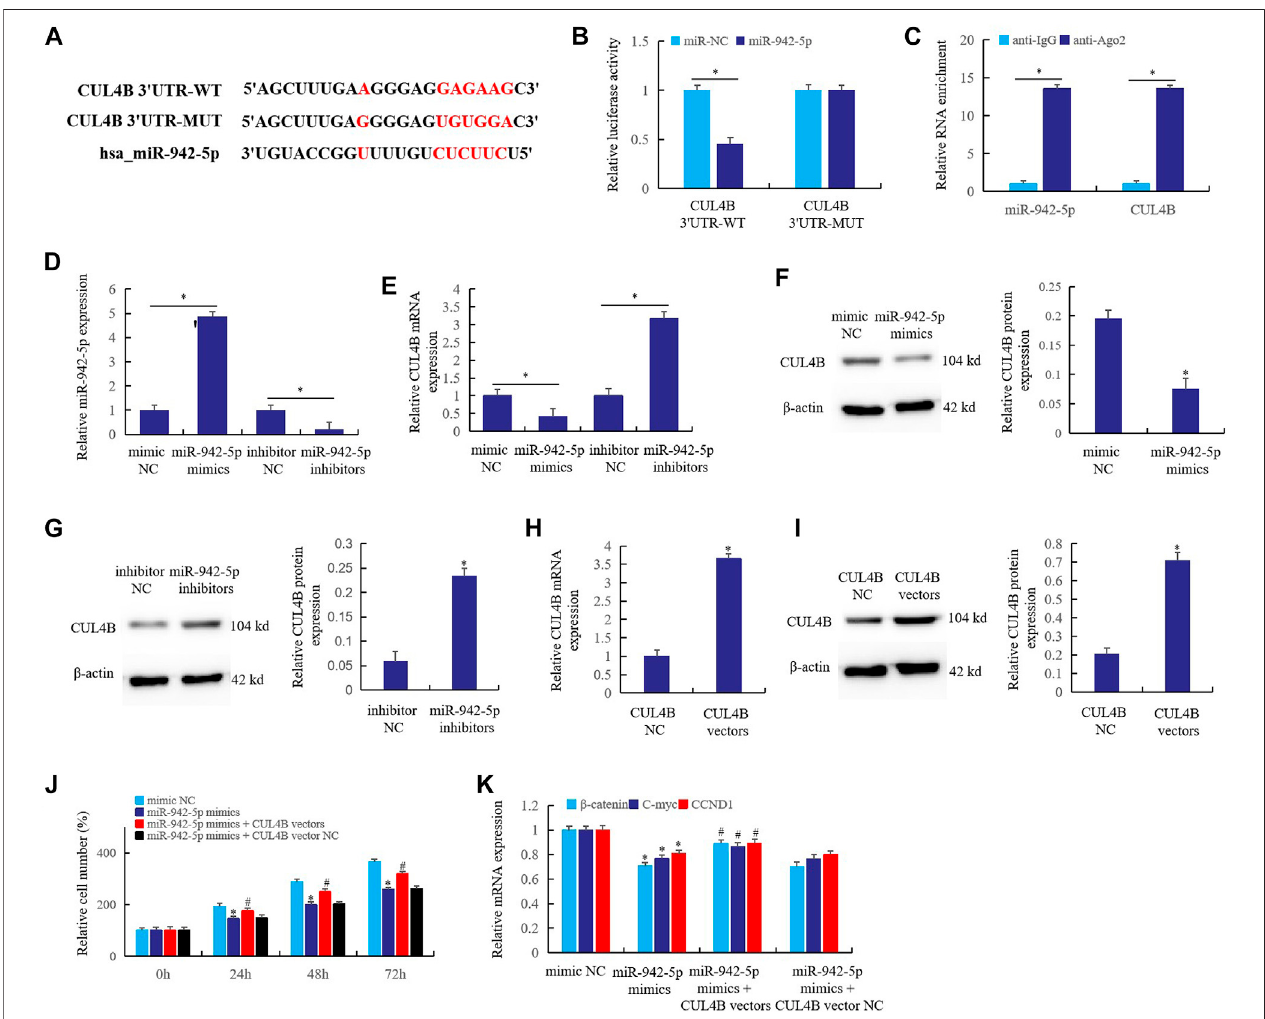
FIGURE5| CUL4B isatargetofmiR-942-5pinRAFLS. (A) theinteractionrelationshipofthe CUL4B andmiR-942-5pwaspredictedbybioinformatics; (B) :double luciferase reporter gene; (C) : RIP assay; the effects of mir-942-5p mimics or inhibitors on the miR-942-5p (D) or CUL4B (E) was detected by real-time qPCR; (F,G) : western blotting; (H,I) : the roles of CUL4B vectors in the CUL4B expression were detected; (J,K) : the reversal effects of CUL4B vectors on miR-942-5p mimics were detected bycell counting and real-time qPCR. For (J,K) , *miR-942-5p mimics group wascompared with mimic NC group; #miR-942-5p mimics + CUL4B vector group was compared with miR-942-5p mimics